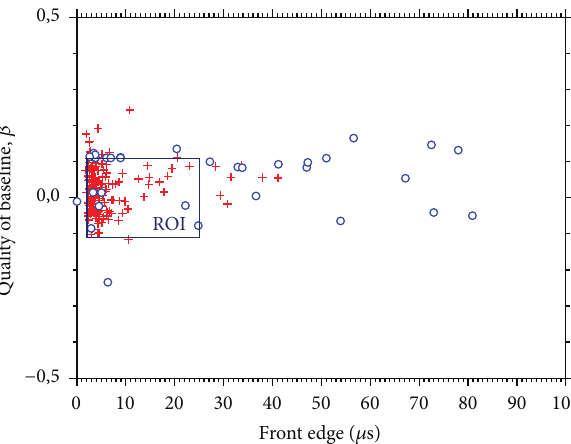
Figure 7: The distribution of the real